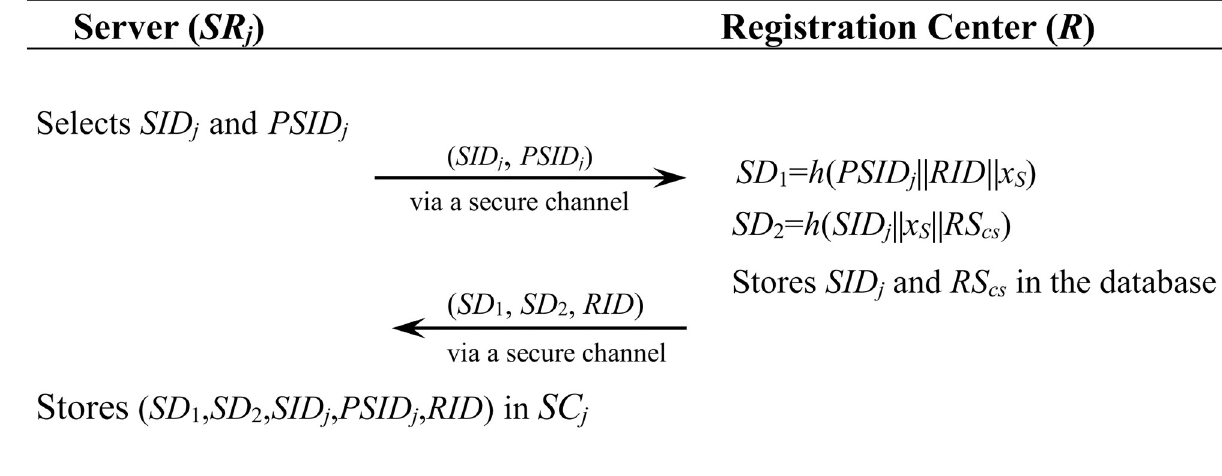
Fig 2. Server registration phase in the proposed